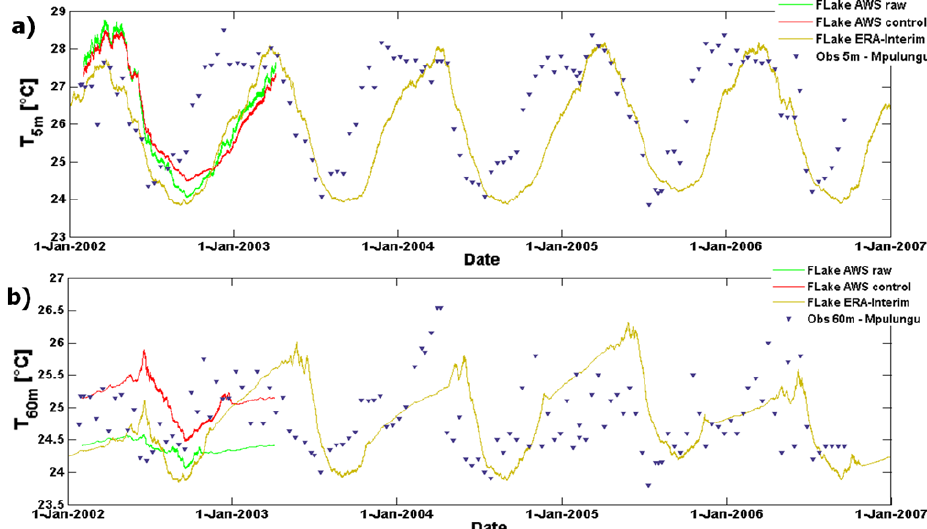
Fig. 8. Modelled and observed temperature evolution at Mpulungu (southern basin of Lake Tanganyika) at (a) 5m, and (b) 60m